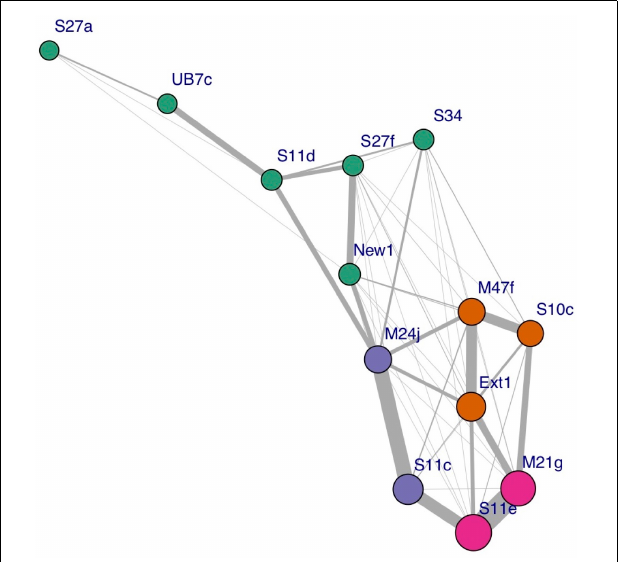
connected it is), and the color represents each cluster